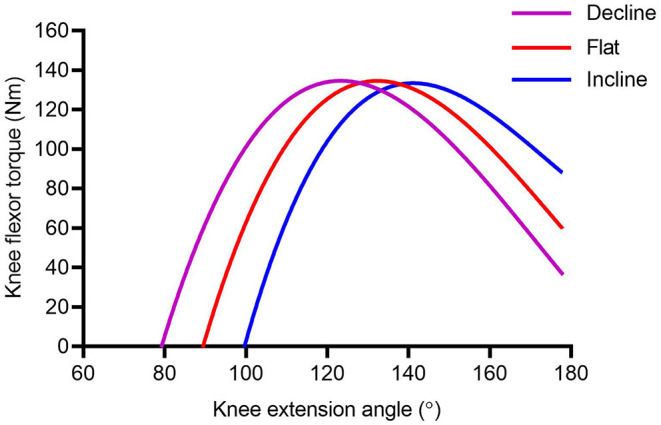
Schematic representation of the muscle torque-length relationship during the NHE performed at different inclinations. A rightward-shift in the torque-length relationship is hypothesized for the incline slope (blue line), and a leftward-shift hypothesized for the decline slope (purple line).